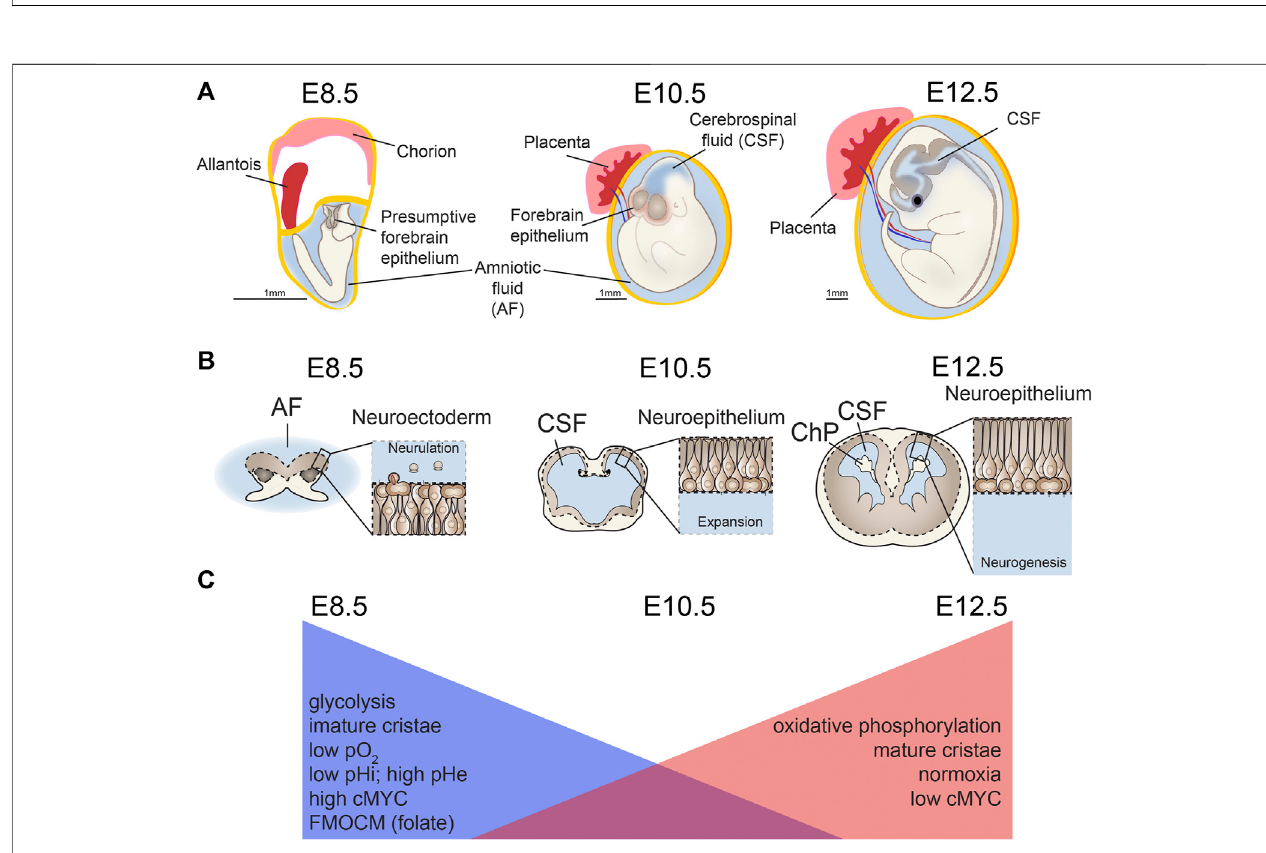
FIGURE 3 | Mitochondria changes during neurulation and early neurogenesis. Major metabolic shifts and changes in mitochondria morphology occur throughout neuraltubeclosure(NTC),alsoknownasneurulation. (A,B) Astheneuroectodermoftheopenneuraltubefoldstogenerateneuroepithelium, (C) metabolismshiftsaway from glycolysis and toward oxidative phosphorylation (OxPhos) along with changes in extracellular and intracellular pH (pHe, pHi) and mitochondrial morphology. Concurrent with this process, chorioallantoic branching further increases oxygen levels (pO 2 ) as development proceeds. Ages are shown for mouse development embryonic days (E) 8.5, E10.5, E12.5. AF, amniotic fl uid; CSF, cerebrospinal fl uid; ChP, choroid plexus. Scale bar (cid:1) 1 mm.